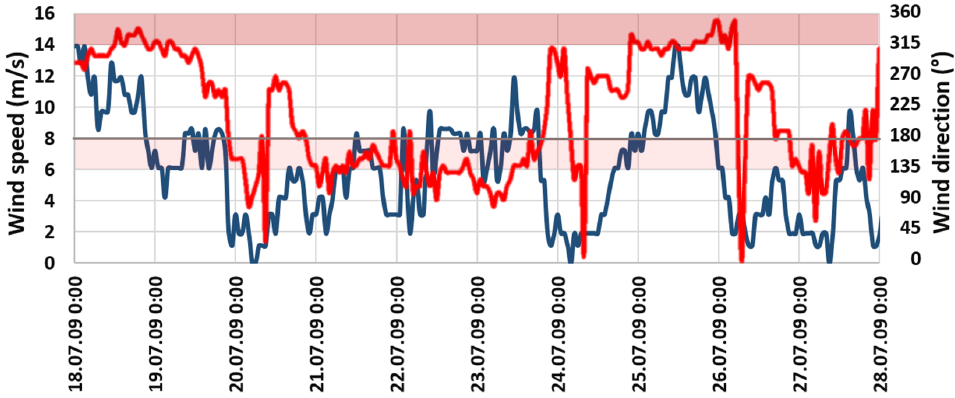
Figure 5. Wind speed modulus (blue line) and wind direction (red line) for the period from 17 July 2009 to 29 July 2009, from Meteociel.fr data. Red area corresponds to winds around N-NW direction and light red area—to winds around S-SE